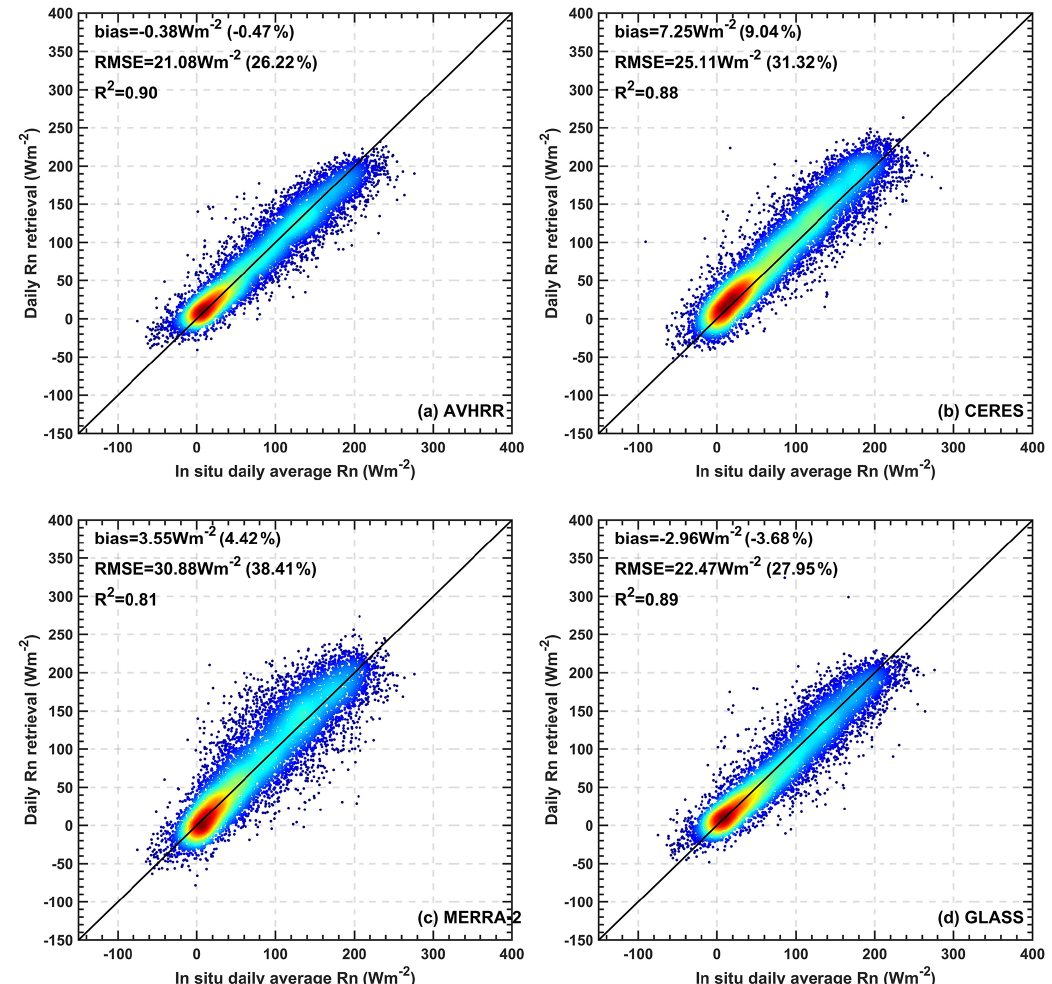
Figure 6. Scatterplots of product validation for (a) AVHRR, (b) CERES-SYN, (c) MERRA-2, and (d) GLASS at the reliable sites.